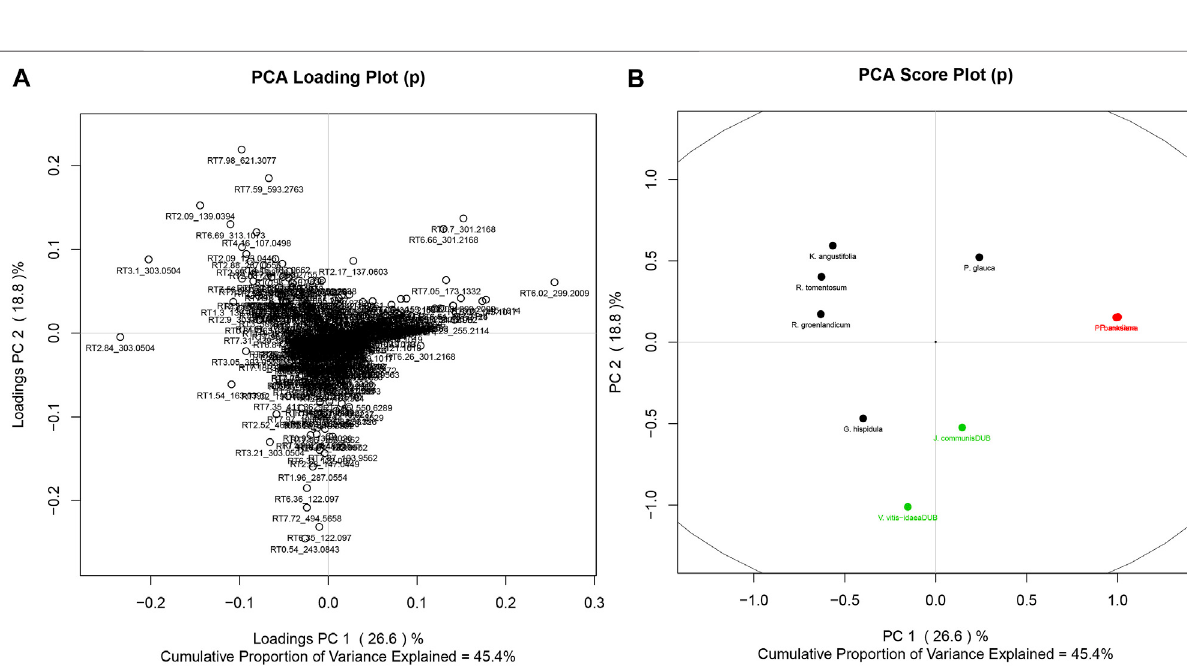
Frontiers in Pharmacology |